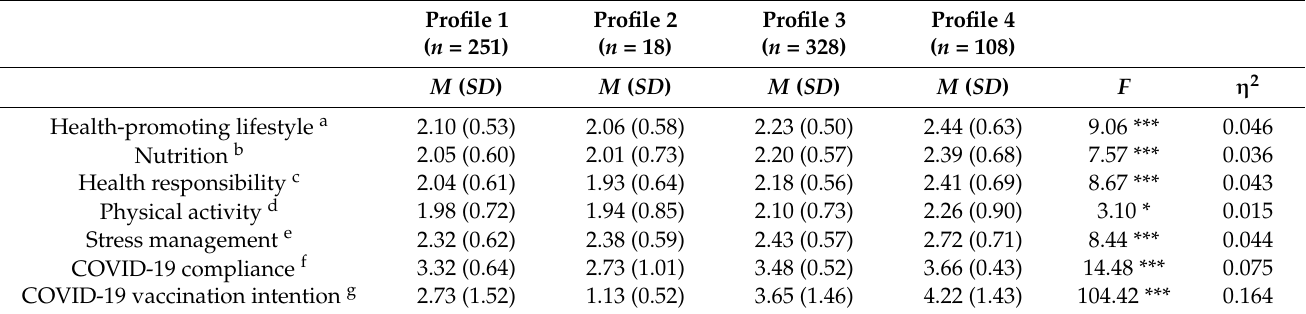
Table 4. Differences between profiles: HPB.